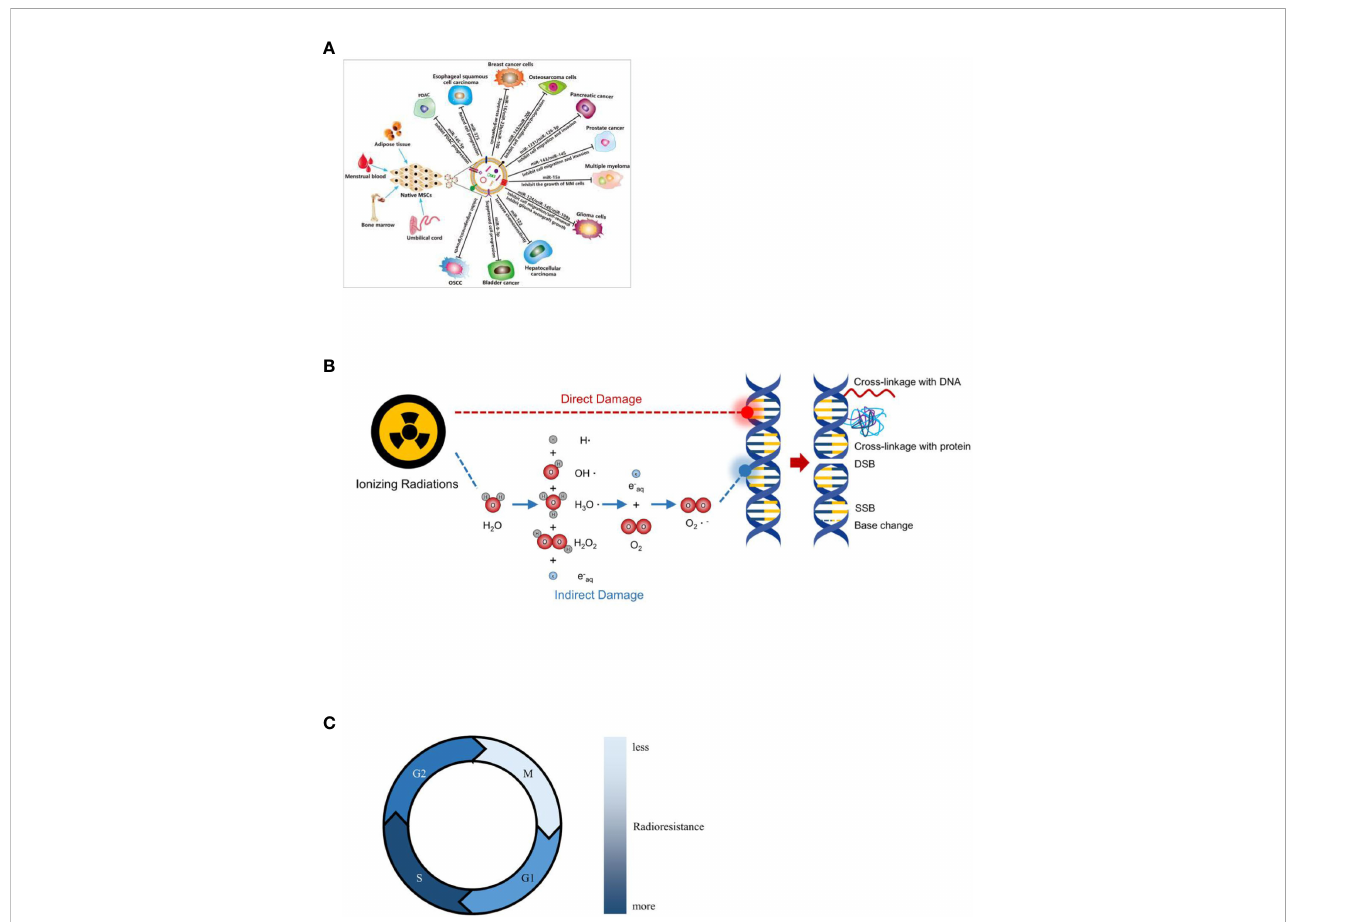
FIGURE 2 Mechanisms associated with nanoradiotherapy sensitization. (A) MSCs derived EVs for cancer therapy. This research was originally published in (83). Copyright(2022) Drug Delivery. (B) Direct and indirect effects of radiation with DNA. (C) Effect of cell cycle on